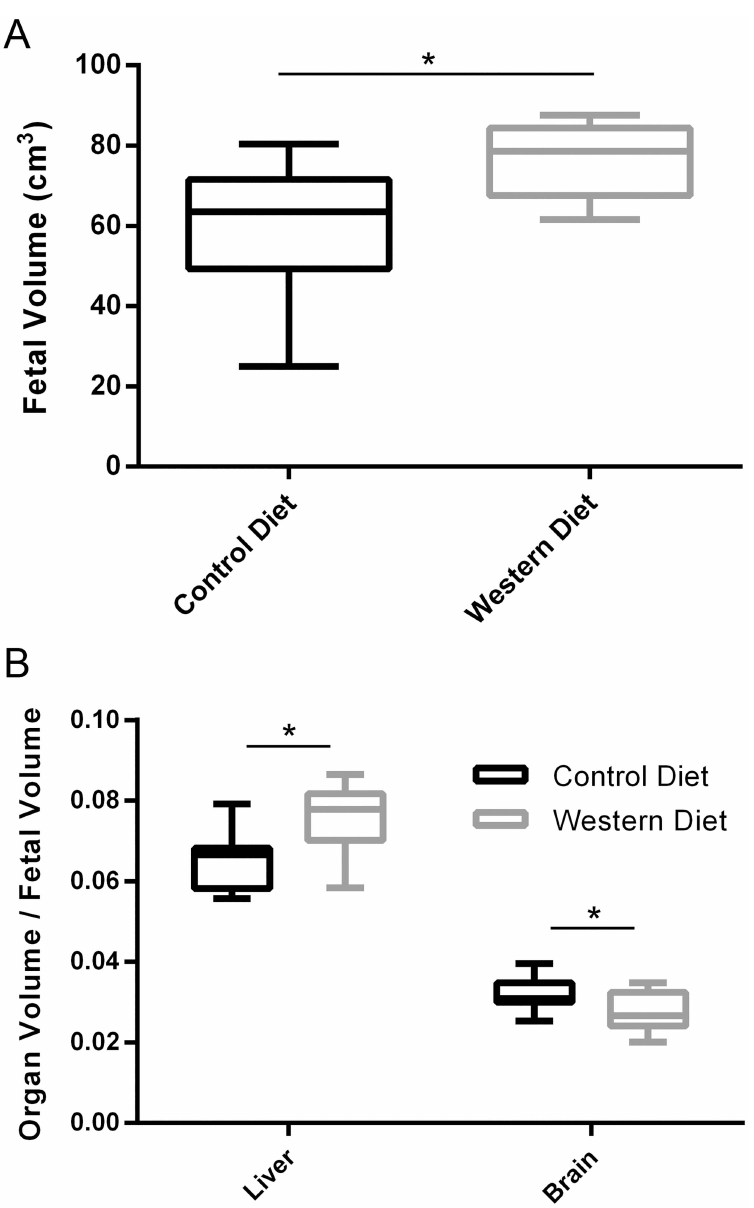
Fig 4. Fetal volume segmentation for Control Diet and Western Diet fetuses. (A) Total fetal volumes. (B) Liver to fetal volume ratio and brain to fetal volume ratio. Data are presented as box and whisker plots as described in the methods section for CD (black) and WD (grey) fetuses. n = 11 and 9 for CD and WD, respectively. (cid:3) P < .05.